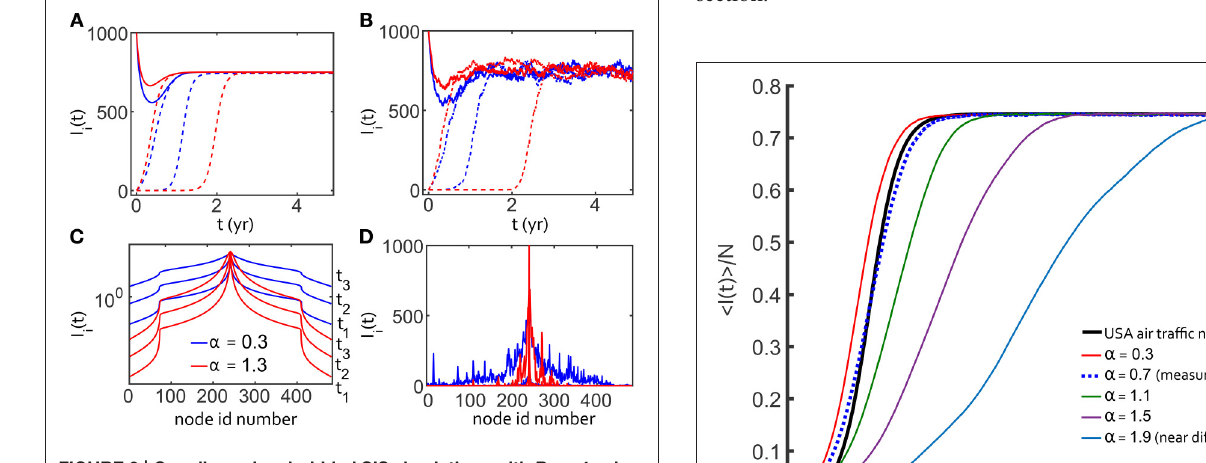
FIGURE 3 | One dimensionalgridded SIS simulations with R 0 = 4 using fractional diffusion. One thousand population units are simulated at each node. Blue denotes a very superdiffusive transport α = 0.3 and red denotes a less superdiffusive α = 1.3 in all panels. (A) Time dependence of the number of infected I i ( t ), for three nodes on the grid for two different values of α . Solid lines show number of infected at the node where the infection was seeded. The dashed lines show data from two other nodes for each value of α , where the outbreak arrives later. (B) Same as previous except with stochastic fluctuations. (C) Spatial dependence, at grid point i , of the infection for three time-points, denoted by t 1 , t 2 , t 3 for both values of α without stochastic effects. Several curves are shown to demonstrate that, as time progresses, the infection rises at distal nodes. (D) Same as (C) except with stochastic dynamics, showing left/right asymmetry and long range fluctuations.